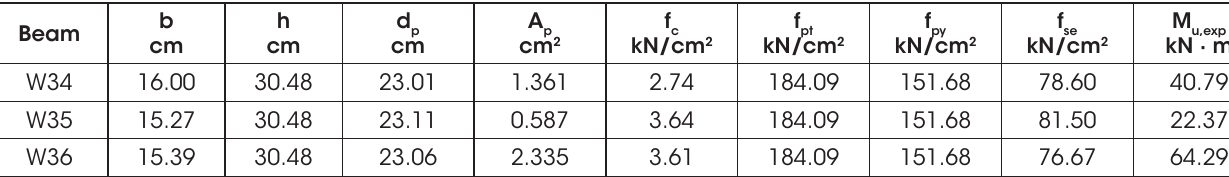
Data of the beams tested by WARWARUK [12]